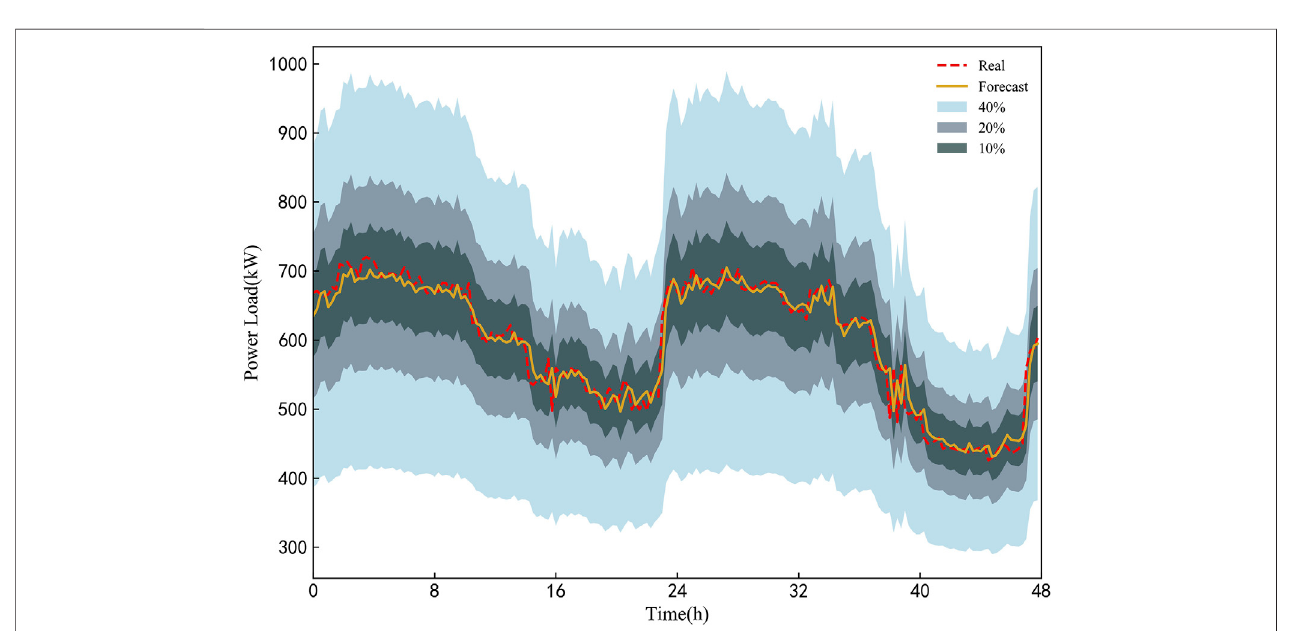
FIGURE 7 | PIs under different con fi dence levels obtained by the proposed ConvLSTM-MDN model in experiment 1.